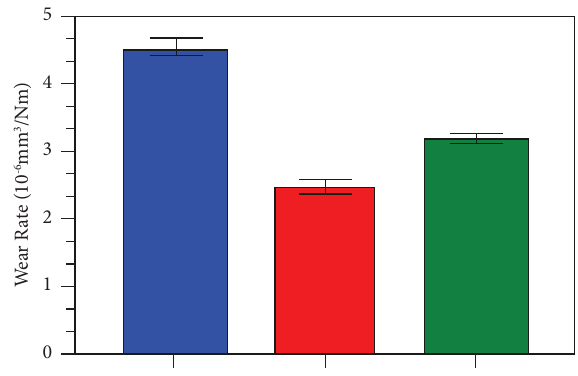
Figure 9: Wear rate result.